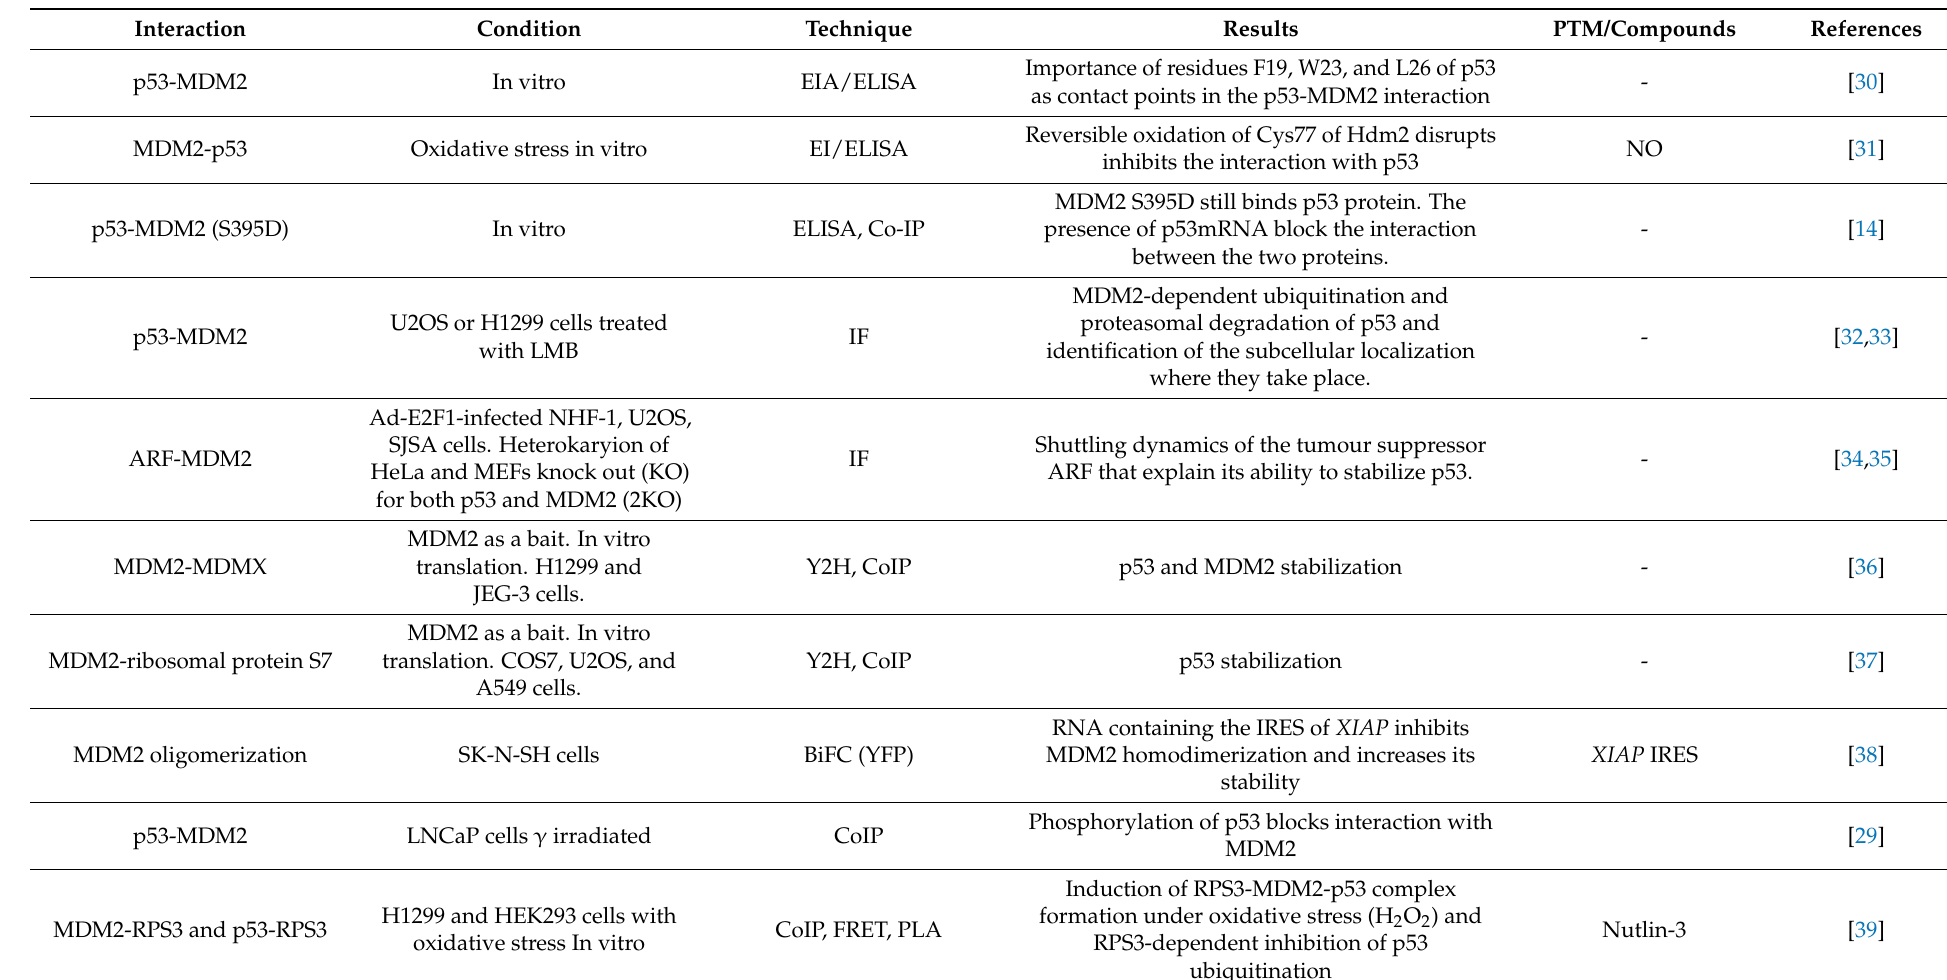
Table 1. Regulation of p53-MDM2 interaction studied with “classic”